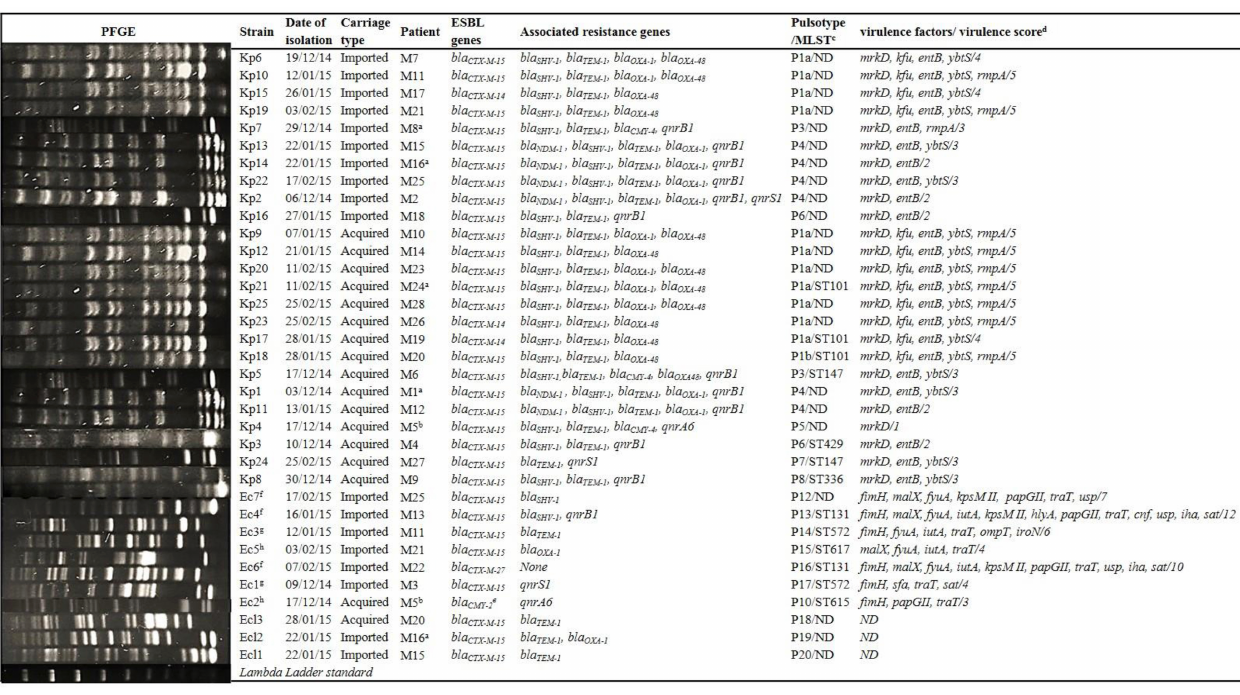
TABLE 2 | XbaI -PFGE profile and characteristics of cefotaxime-resistant Enterobacteriaceae strains collected in intestinal flora of